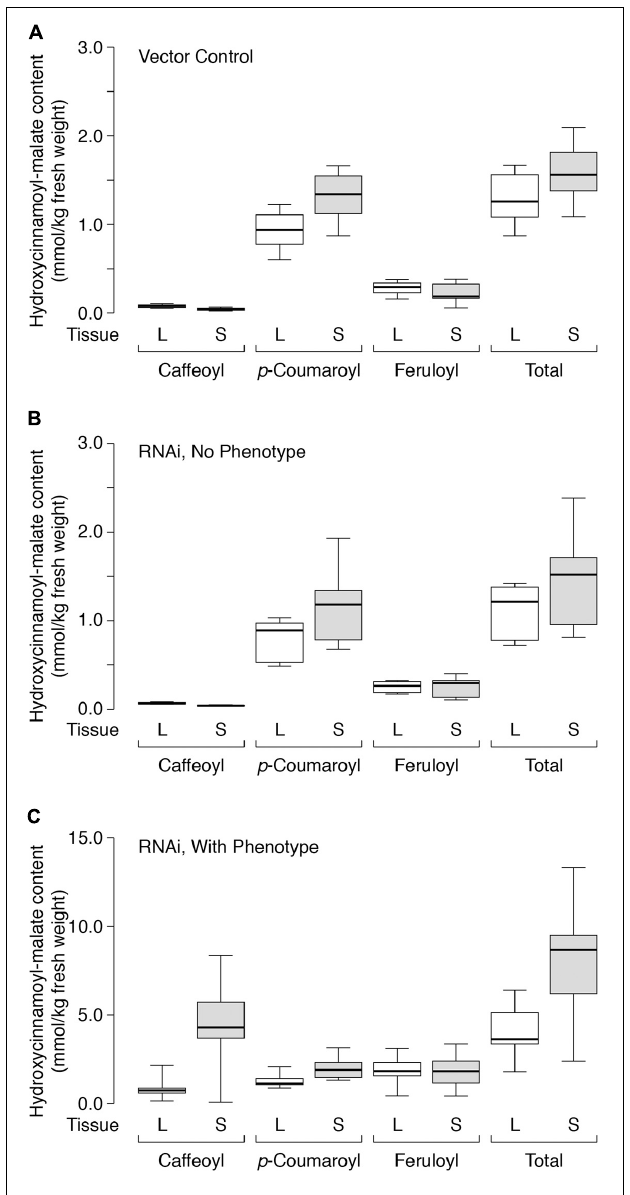
FIGURE 6 | Hydroxycinnamoyl-malate accumulation in leaves (L, white boxes) versus stems (S, gray boxes) of HMT-expressing alfalfa (A) retransformed with vector only (eight independent transformants), (B) retransformed with the CCOMT RNAi construct but not showing the caffeoyl-malate phenotype (six independent transformants), or (C) retransformed with the CCOMT RNAi construct and showing the caffeoyl-malate phenotype (10 independent transformatns). Center lines show the medians, box limits indicate the 25th and 75th percentiles as determined by R software, whiskers extend to minimum and maximum values.